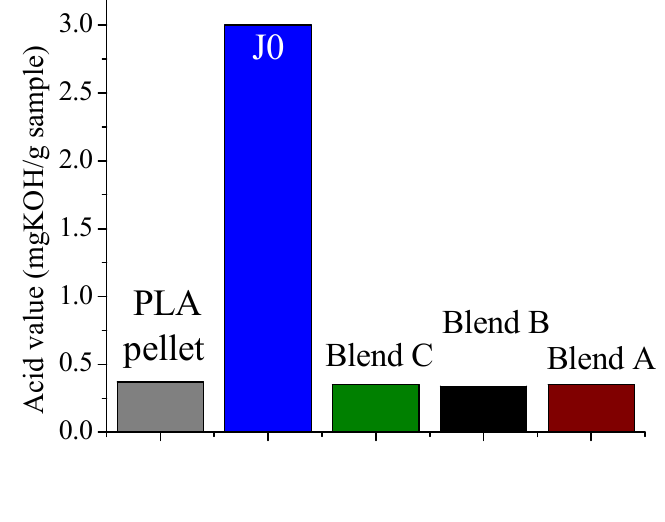
Figure 8. Acid value of the blends (blend compositions shown in Table